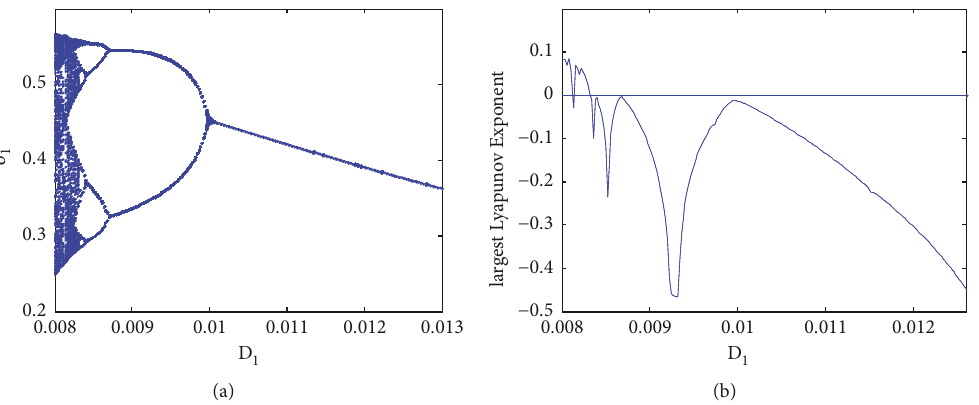
Figure 10: (a) Bifurcation diagram. (b) Largest Lyapunov exponent.